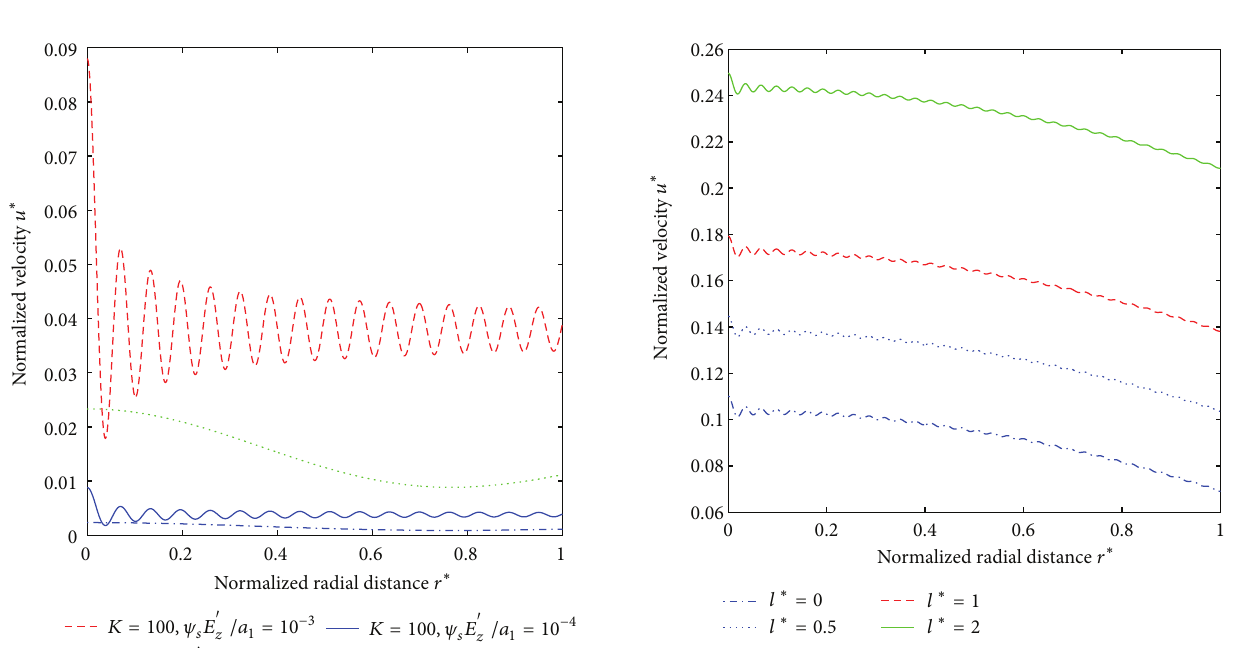
Figure 3: Typical velocity profile for various different values of slip length 𝑙 ∗ at a typical time 𝑡 ∗ = 𝜃/2𝜋 , obtained with 𝜓 𝑠 𝐸 󸀠 𝑧 /𝑎 1 = 10 −4 , 𝐾 = 200